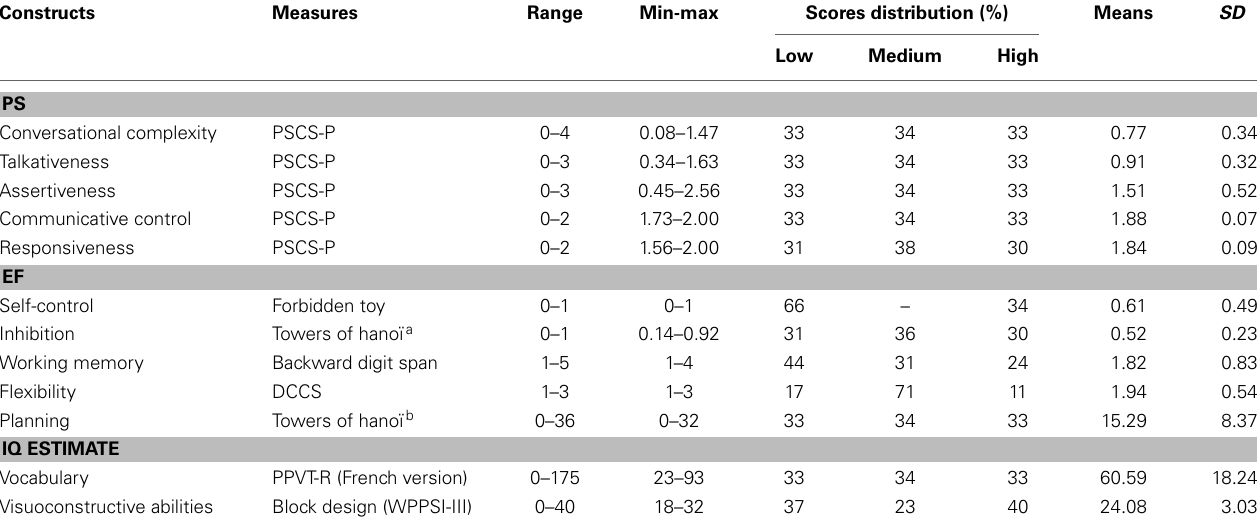
Table 2 | Descriptive statistics for the executive function (EF), intellectual quotient (IQ), and pragmatics skills (PS) measures.